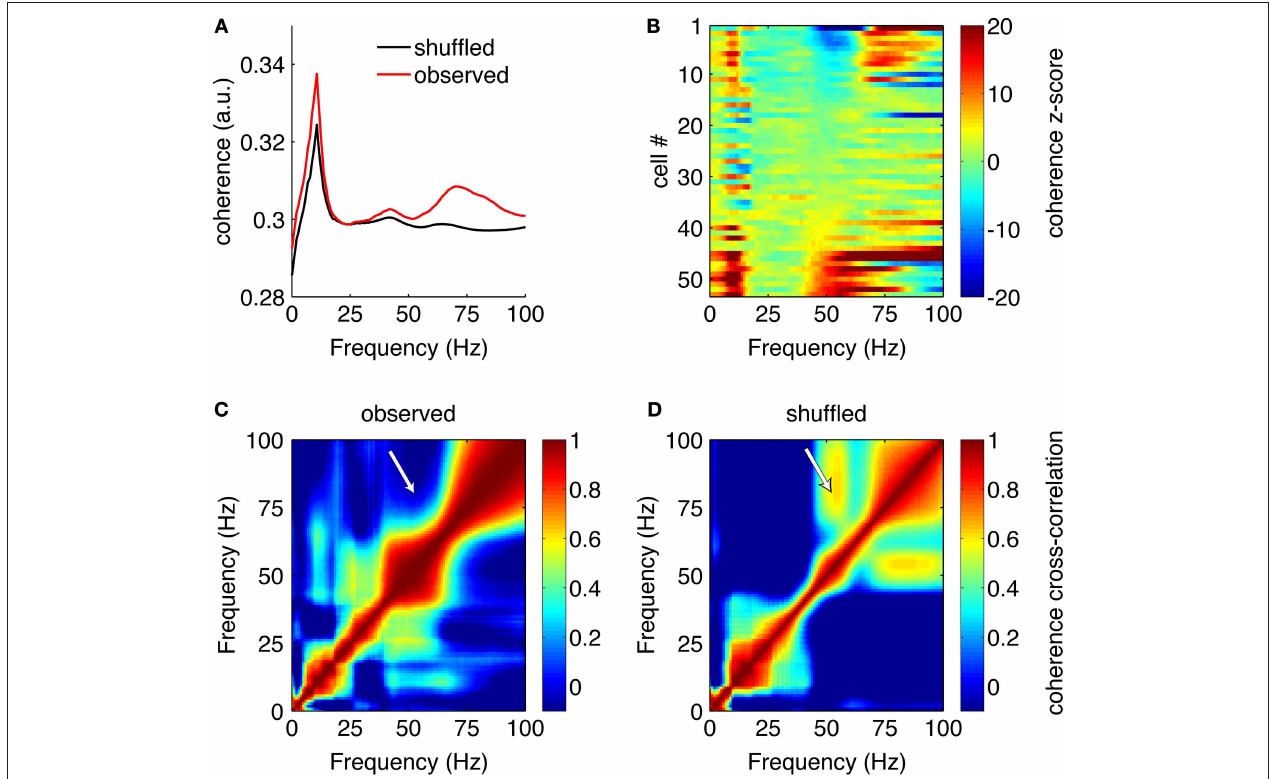
FIGURE 14 | Distinct putative fast-spiking interneurons (FSIs) cohere with gamma-50 or gamma-80. (A) Average spike-fi eld coherence for all FSIs (red) and the average obtained from randomly interspike-interval-shuffl ed bootstrap samples (black) shows overall coherence in the wide gamma band that cannot be explained by fi rst- or second-order spiking statistics. (B) Coherence for all FSIs individually, z -scored against the distribution of bootstrap samples, ordered